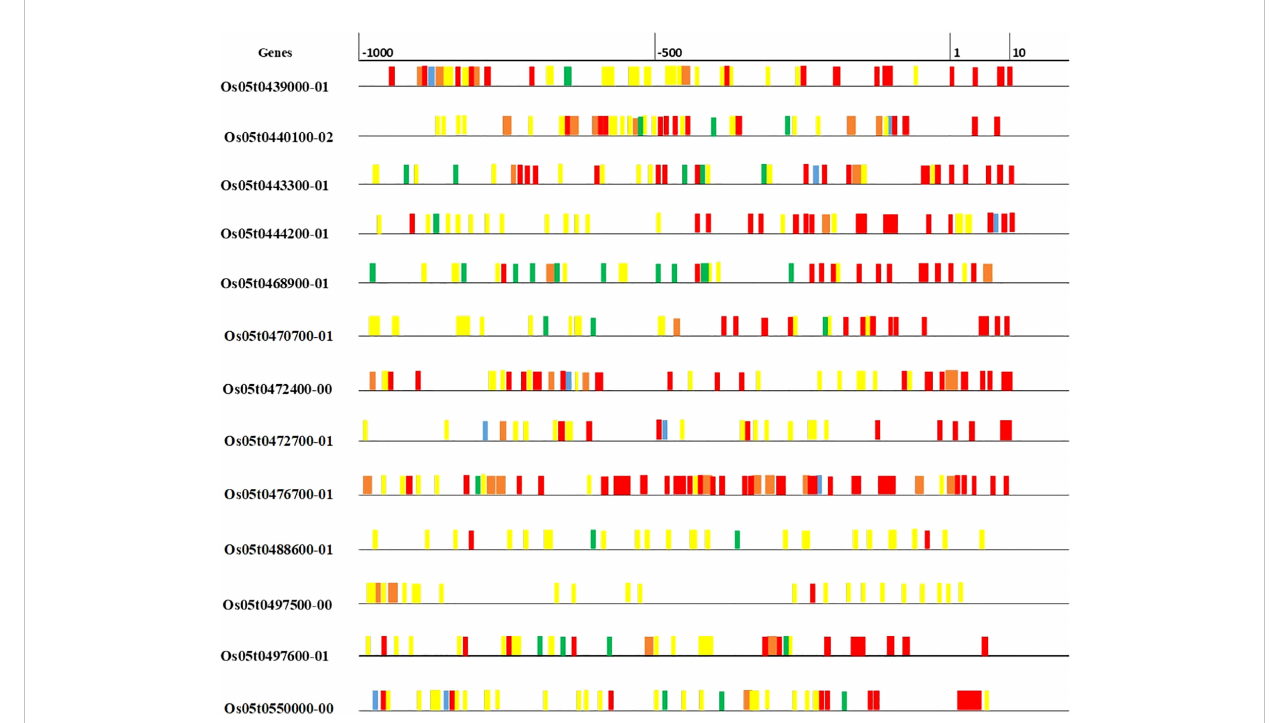
FIGURE 3 Cis-regulatory elements in the upstream region (500 Kb) of predicted genes for grain Zn. Various elements are associated with physiological functions such as submergence tolerance (blue), merismatic (orange), disease resistance (yellow), light regulation (green), amylase synthesis (red) were indicated using different